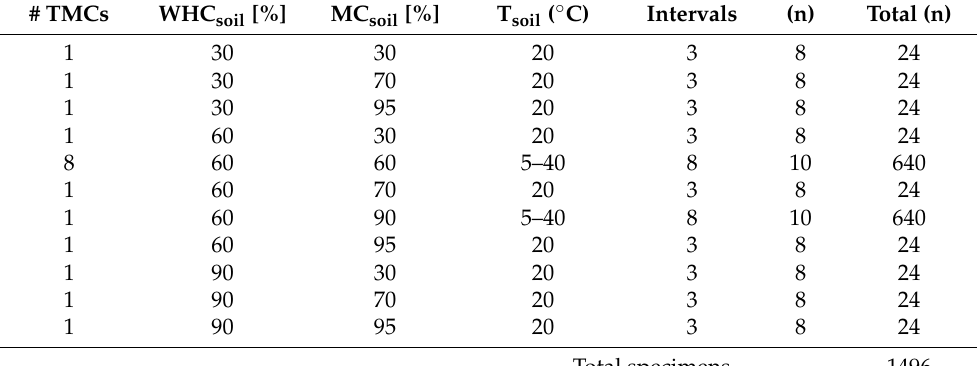
Table 2. A subset of wood decay data (ML wood ) with respective moisture and temperature conditions, taken from Part 1 [34], with moisture- and temperature-induced dose components calculated to deliver a model describing ML wood as a function of cumulative total daily